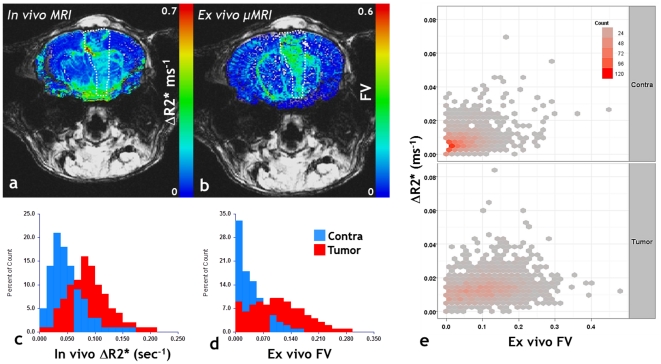
Bridging macroscale and microscale MRI.(a) In vivo macrovascular CBV (ΔR2*) map. (b) Co-registered ex vivo fractional blood volume (FV) map obtained from μMRI. The tumor ROI is highlighted by hatched lines in each panel and FV ranges from 0 to 1. (c) Histograms showing the relative distribution of the ΔR2* between tumor and contralateral ROIs. (d) Histograms showing the relative distribution of the FV between tumor and contralateral ROIs. Tumor blood volume is elevated relative to the contralateral brain across these “multi-scale” data. (e) 2D histograms of the macrovascular CBV measured in vivo versus the fractional blood volume assessed ex vivo. These data further demonstrate the utility of multi-scale imaging of brain tumor vascularization.